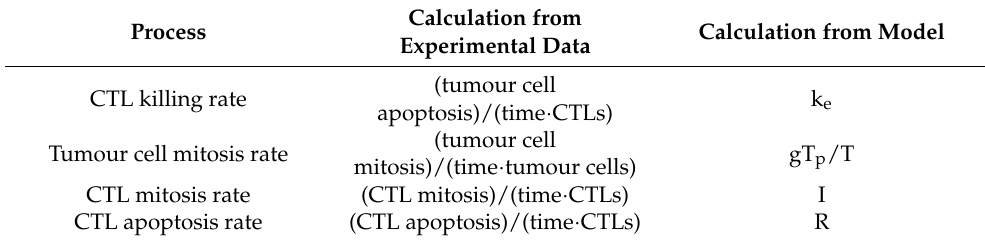
Table 1. Calculation of intravital process rates from experimental data and from ODE